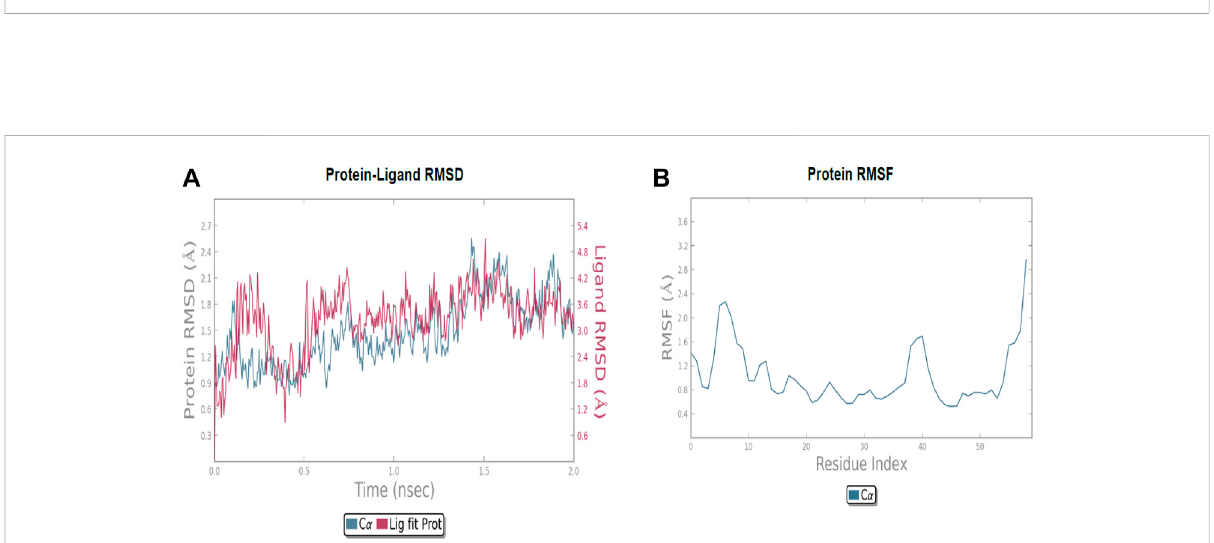
FIGURE 12 (A) RMSD of protein – ligand ( 6b 3W2S) throughout 2ns and (B) RMSF of the